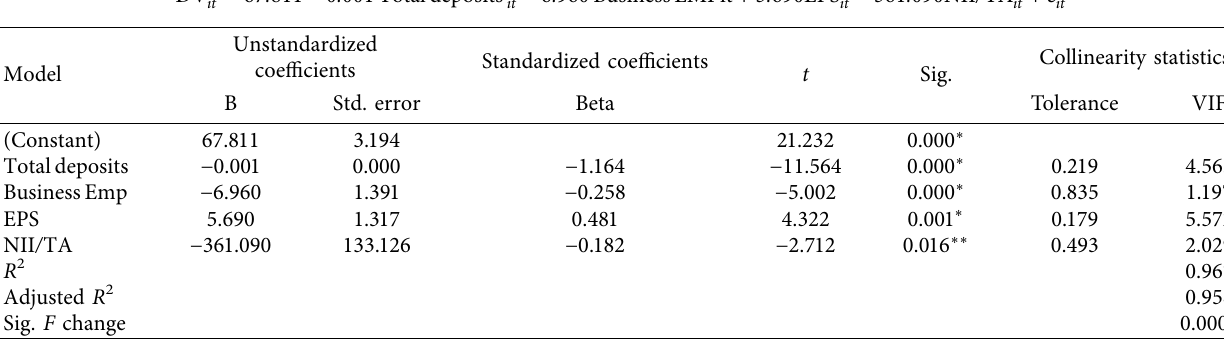
Table 4: Summary of Islamic banks’ efficiency model.